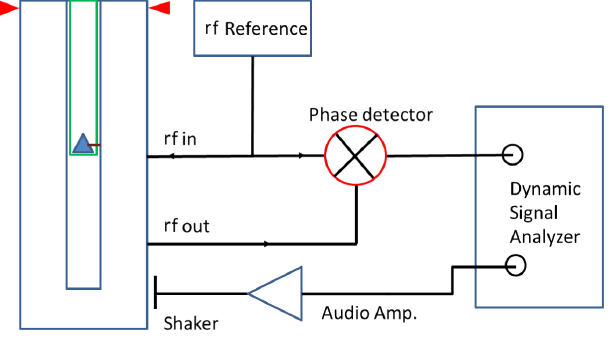
FIG. 9. Schematic of the test bench.